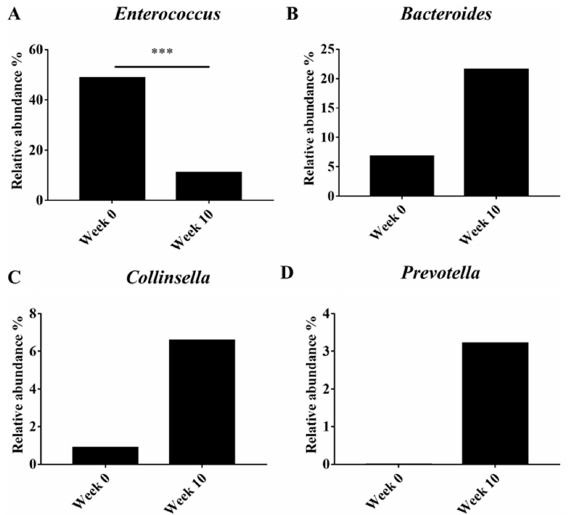
Figure 3. Comparison of microbiota between obese dogs according to synbiotic preparation con- taining L. gasseri BNR17 supplementation. Genus: ( A ) Enterococcus , ( B ) Bacteriodes , ( C ) Collinsella , ( D ) Prevotella . *** p < 0.001.